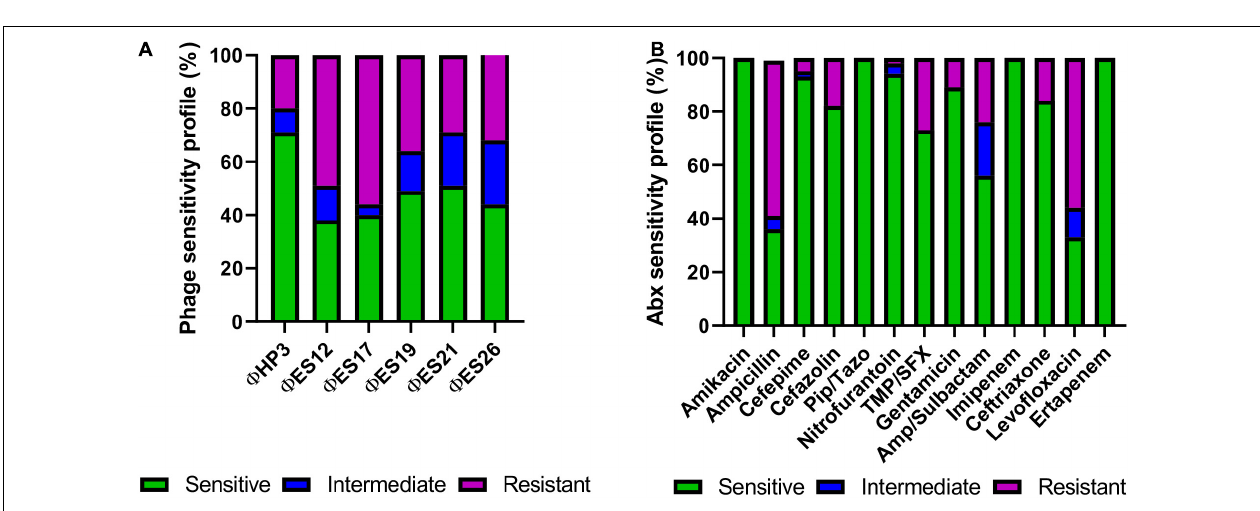
FIGURE 4 | Phage lysis phenotypes and antibiotic sensitivities of 54 strains of E. coli isolated from the urine of patients with SCI. (A) Susceptibility of SCI E. coli strains ( N = 54) based on phage virulence (EOP) against each strain. (B) Antibiotic susceptibilities of SCI E. coli strains ( N = 54, except for Pip/Tazo N = 46).